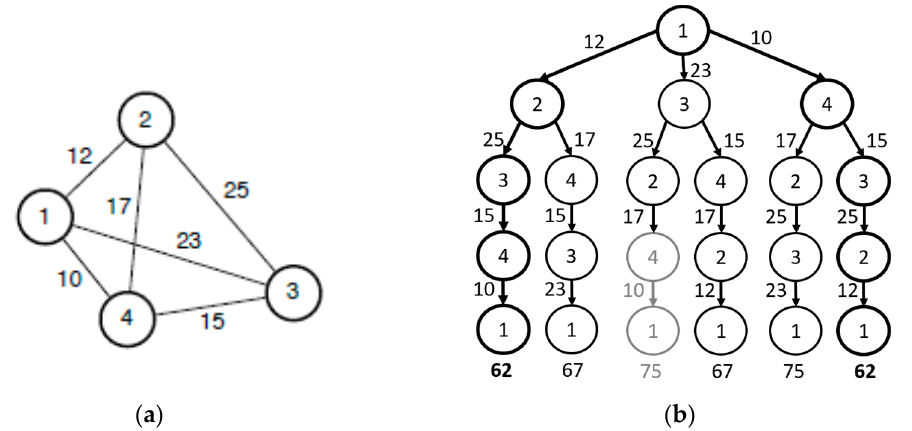
Figure 3. ( a ) Illustration of the TSP Problem; ( b ) Illustration of the solution.